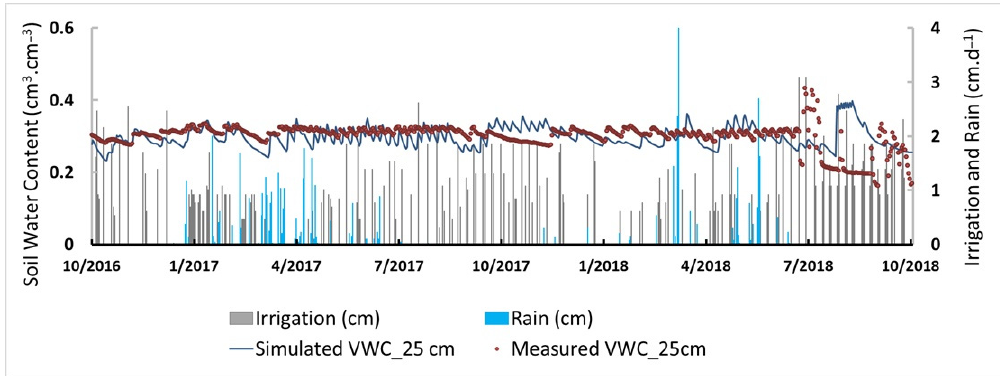
Figure 6. Effects of irrigation and rain on the measured and HYDRUS-1D simulated soil water contents at a depth of 25 cm at the PSL site.